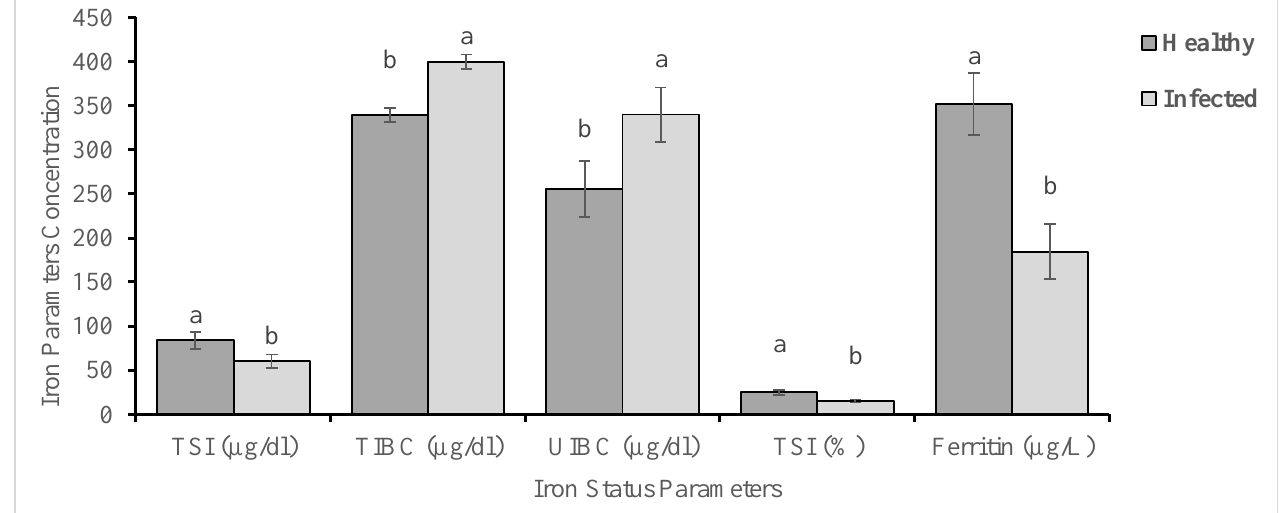
Figure 4 . Effects of infection with Trypanosoma evansi in camels on TSI, total serum iron; TIBC, total iron- binding capacity; UIBC, unsaturated iron-binding capacity; TS, transferrin saturation. Mean±SE. a-b Bars for each parameter lacking a common letter differ significantly at